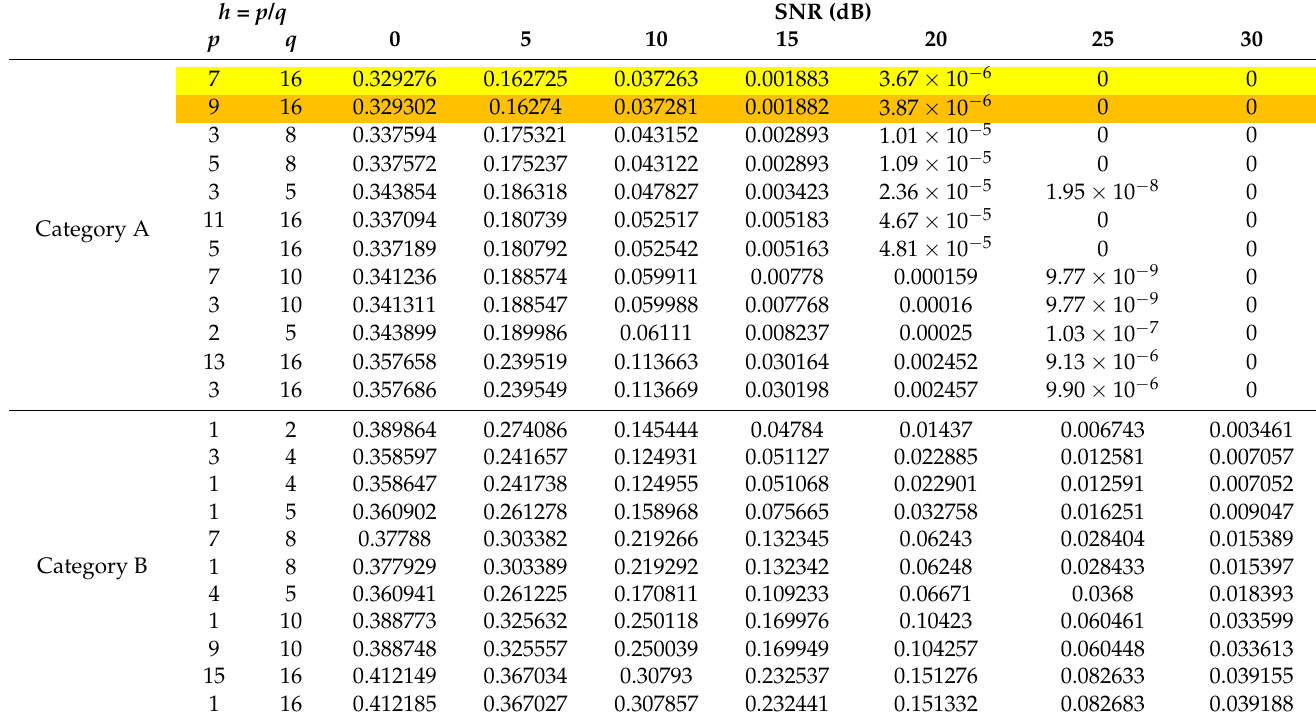
Table 3. BER values for various modulation indices and SNRs (sorted on values of BER at SNR = 20